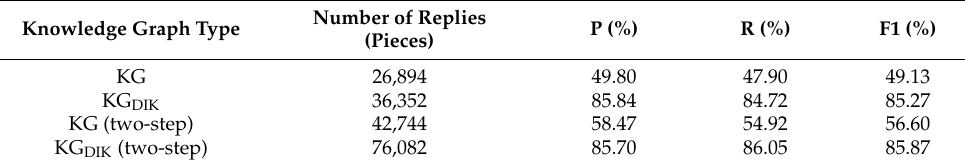
Table 6. The experiment results of intelligent QA by KG and KG DIK . Knowledge Graph